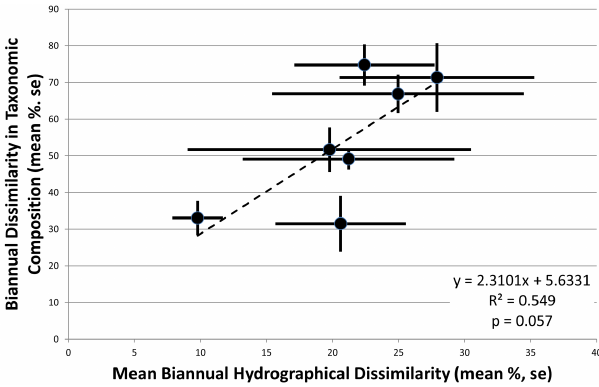
Fig. 12. Relationships (marginally significant) between taxonomi- cal dissimilarity of communities between consecutive years and the dissimilarity of hydrographical conditions (direction and velocity of currents, salinity, temperature) among the same pairs of years.